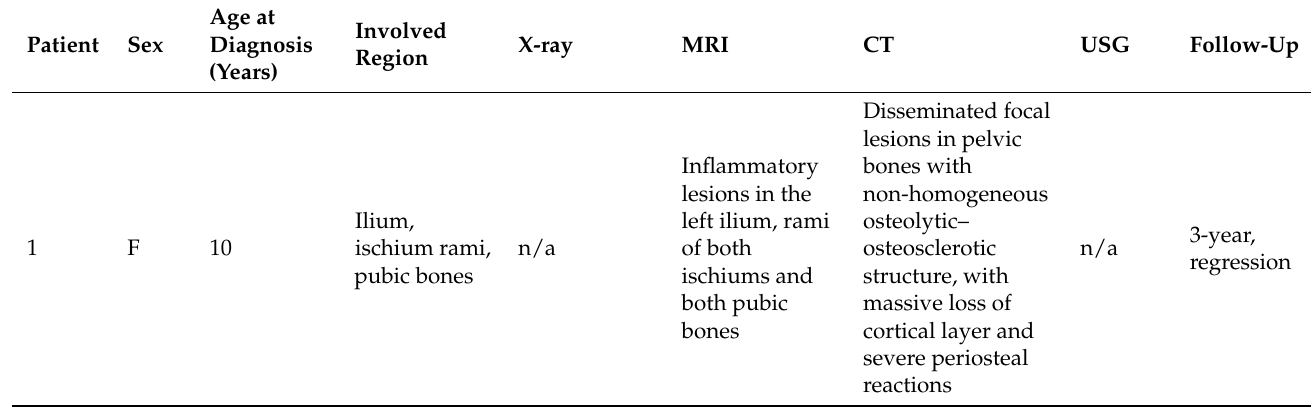
Table 3. Detailed results of baseline and follow-up imaging studies in CRMO